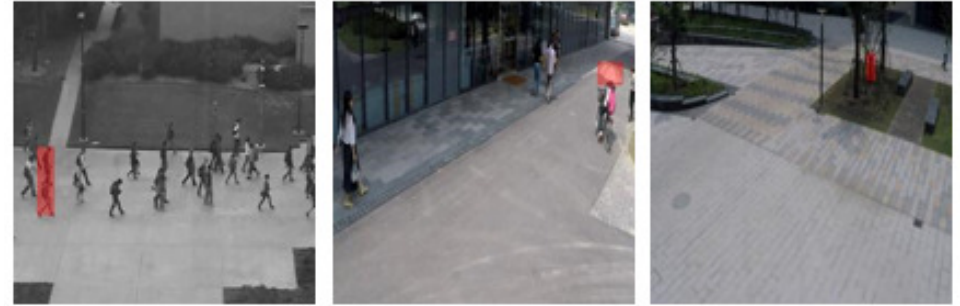
Figure 9. Several imperfect cases of anomaly localization affected by Mask R-CNN detector. Left : Too large bounding box; Middle : Too small box; Right : Wrong object. Best viewed in